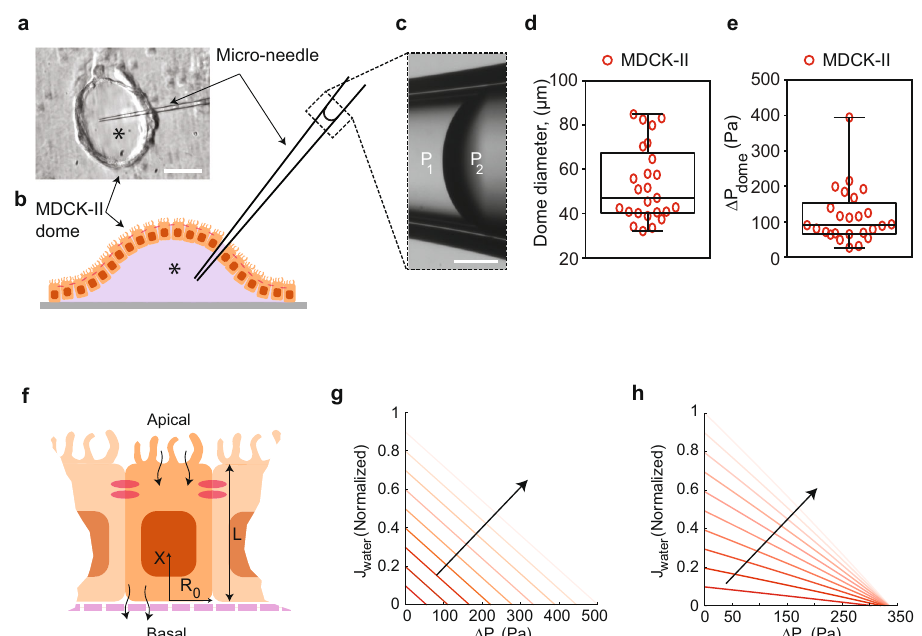
Fig. 2 Validation of Δ P in epithelial domes and theoretical pump performance curves. a Schematic of micro-needle inserted into a fl uid fi lled epithelial dome. Asterisk indicates lumen side in the dome schematic ( b ). c Dashed rectangle shows phase-contrast image of oil-media interface in the micro-needle. The curvature of the interface was used to measure the hydrostatic pressure in the domes. P2 and P1 indicate the hydrostatic pressure at the oil-media interface in the micro-needle. Scale bar = 20 µ m. d Measured dome sizes in an MDCK-II epithelium on glass. e Measured hydrostatic pressure in fl uid- fi lled domes in an MDCK-II epithelium on glass. Error bars indicate standard deviation. For the box plots, lower and upper box boundaries 25th and 75th percentiles, respectively, line inside box median, lower and upper error lines 10th and 90th percentiles, respectively, fi lled circles indicate data points. f Schematic of the theoretical model of fl uidic pumping by epithelial cells. Flow fi eld along the x-direction and apical and basal surface water and solute fl uxes are considered by the model. g Theoretical pump performance curve calculated for the model epithelium using active fl ux in Eq. (19) in Supplementary Information notes, where J is the transepithelial fl uid fl ux and Δ P is the hydrostatic pressure gradient. h Converging nature of PPC to a constant Δ P* was achieved by changing the J a active to Eq. (20) (Supplementary Information notes). Lighter lines indicate decrease in apical osmolarity. The fl uid fl ux values were normalized against the maximum J 0 . Black arrow indicates decreasing osmolarity on the apical